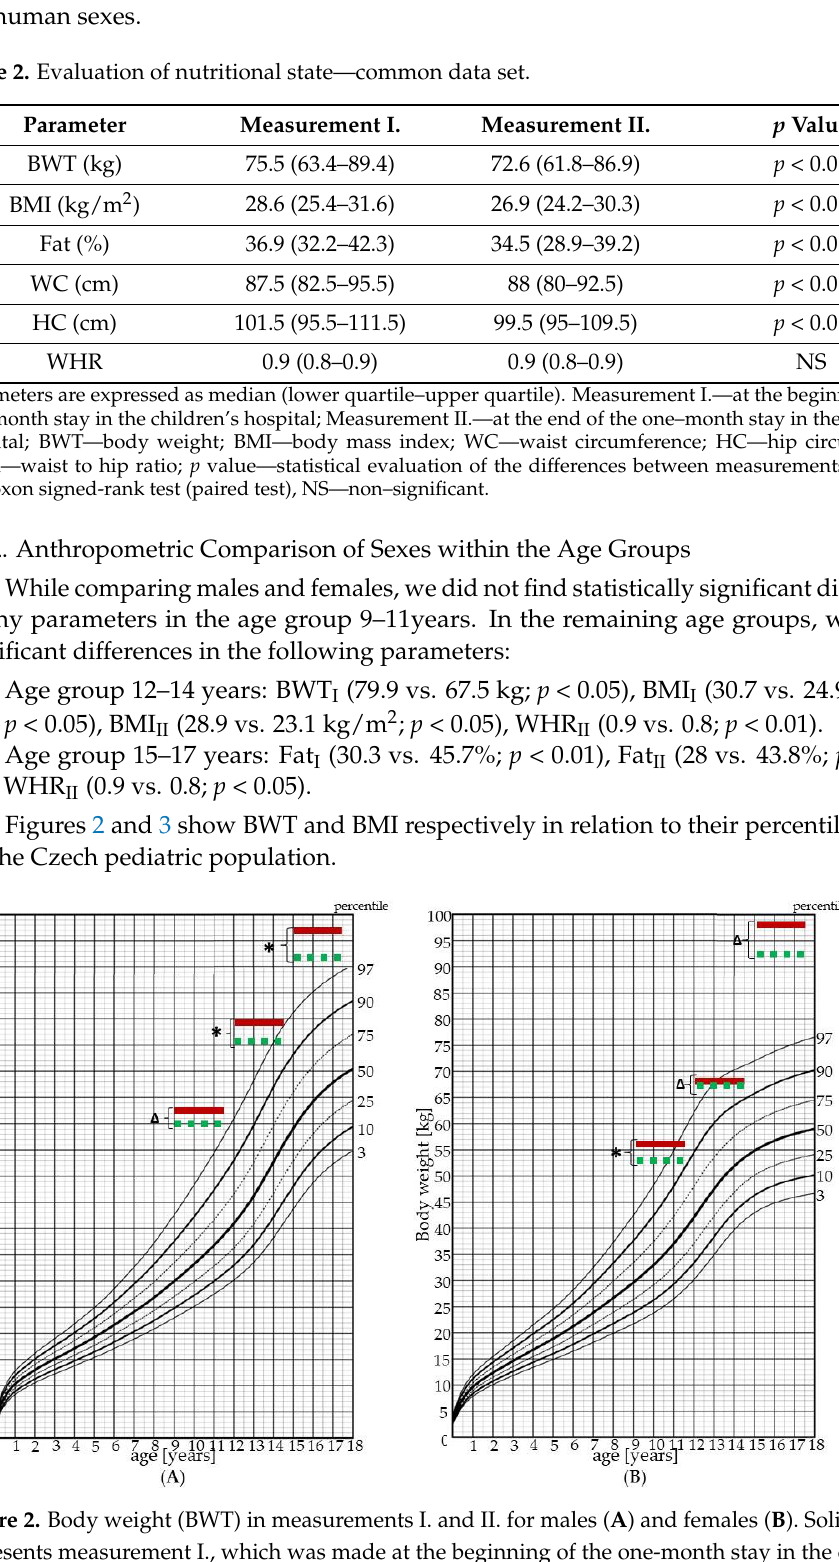
Figure 3. Body mass index (BMI) in measurements I. and II. for males ( A ) and females ( B ). Solid red line represents measurement I., made at the beginning of the one-month stay in the children’s hos- pital, dashed green line represents measurement II., made at the end of the one-month stay in the children’s hospital. *— p value is less than 0.01; Δ— p value is less than 0.05; p value—statistical eval- uation of the differences between the measurements I. and II., Wilcoxon signed-rank test (paired test). Table 3 shows the percentage of fat tissue in both sexes in all age groups, as well as the physiological ranges of fat tissue percentage for children of respective ages.